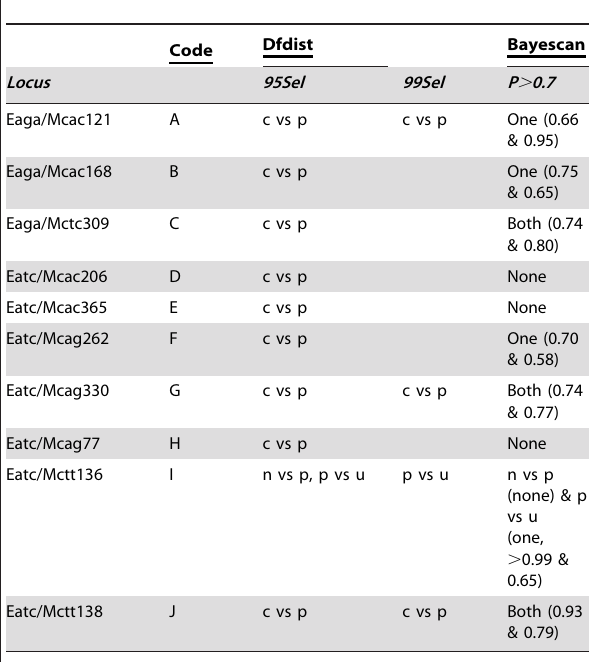
Table 4. Hypoplectrus AFLP loci with F ST values that were significantly higher than expected in the absence of selection between colour morphotypes, in pair-wise comparisons at two separate locations, using both Dfdist and Bayescan outlier detection